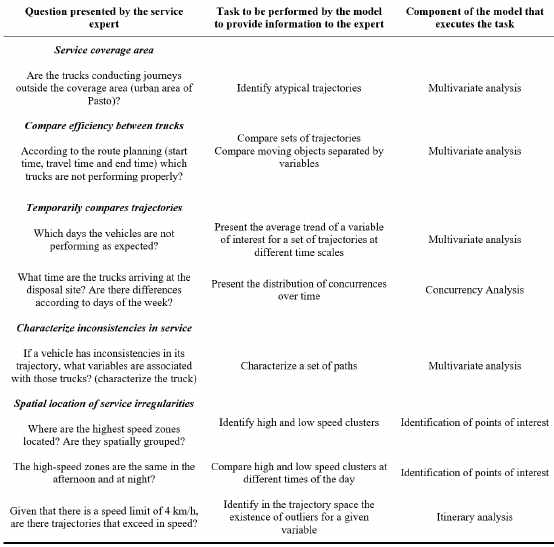
Table 1. Procedure for transforming experts' concerns into tasks executed in the AVIMEU